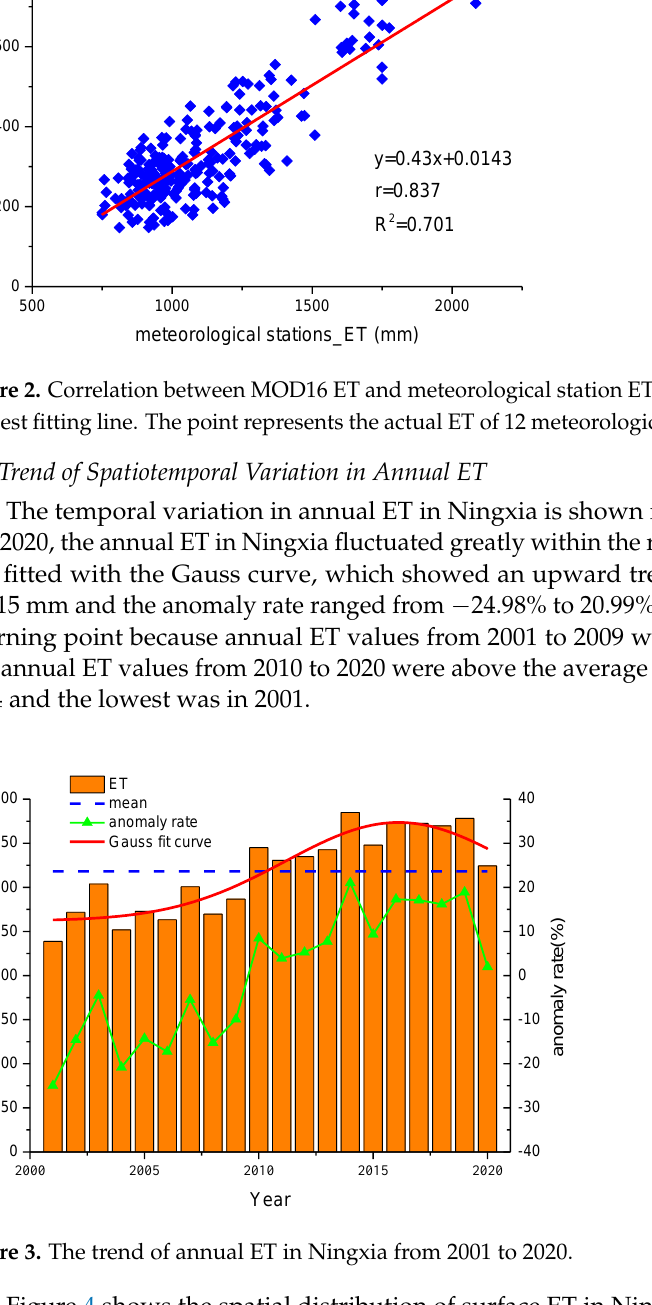
Figure 2. Correlation between MOD16 ET and meteorological station ET data. The red line repre- sents the best fitting line. The point represents the actual ET of 12 meteorological stations from 2001 to 2020.